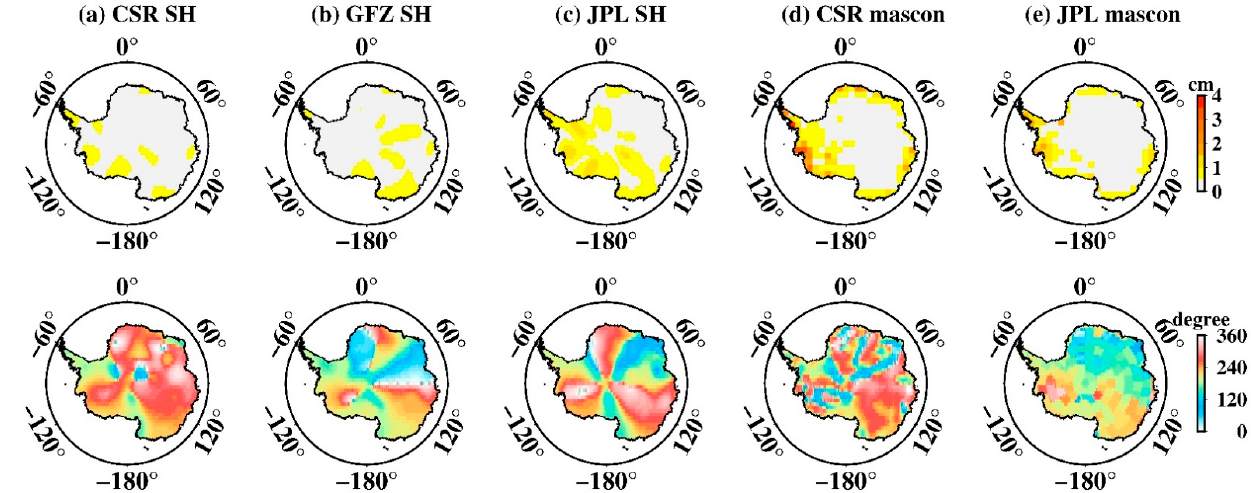
Figure 8. S 1 tide aliasing over Antarctica. ( a – e ) Spatial amplitude and the corresponding phase maps estimated from CSR SH data, GFZ SH data, JPL SH data, CSR mascon data, and JPL mascon data, respectively.